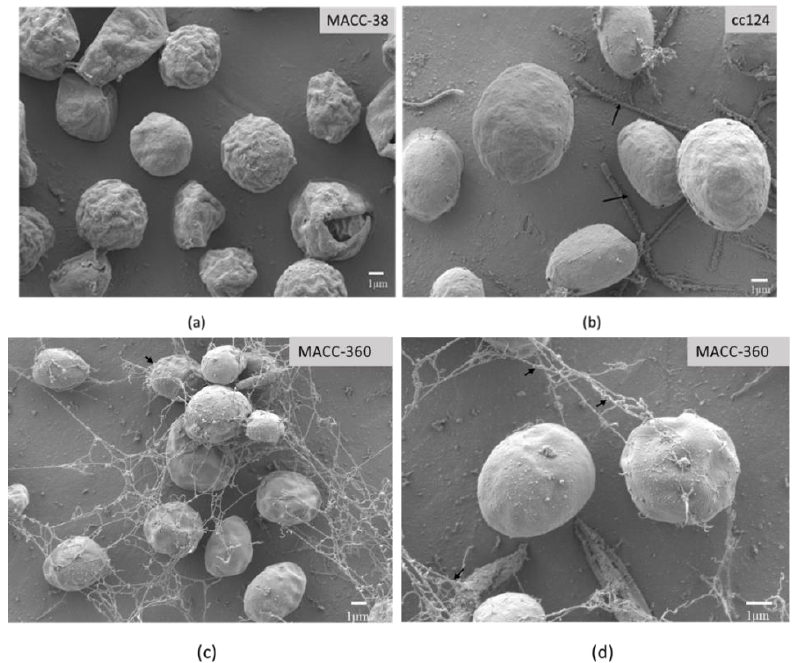
Figure 2. Scanning electron microscopy pictures of the three strains: ( a ) Chlorella MACC-38; ( b ) C. reinhardtii cc124; ( c ) Chlorella MACC-360 at 5000 × magnification; ( d ) Chlorella MACC-360 at 10,000 × magnification. Black arrows on ( b ) show flagella; black arrows on ( c ) show aggregation or clustering of cells while black arrows on ( d ) show the extracellular material connecting one cell to another in the cell aggregations/matrix.